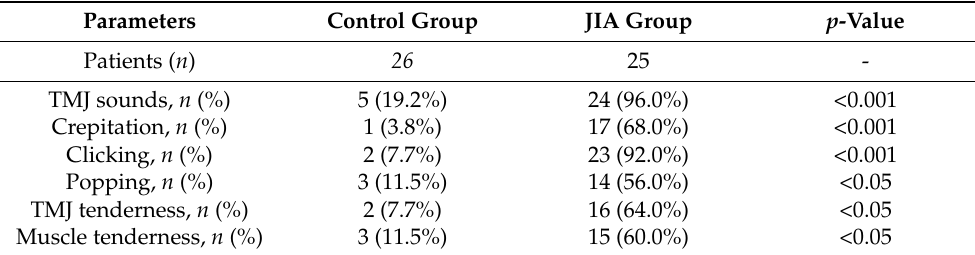
Table 3. Signs of TMJ dysfunction in the two